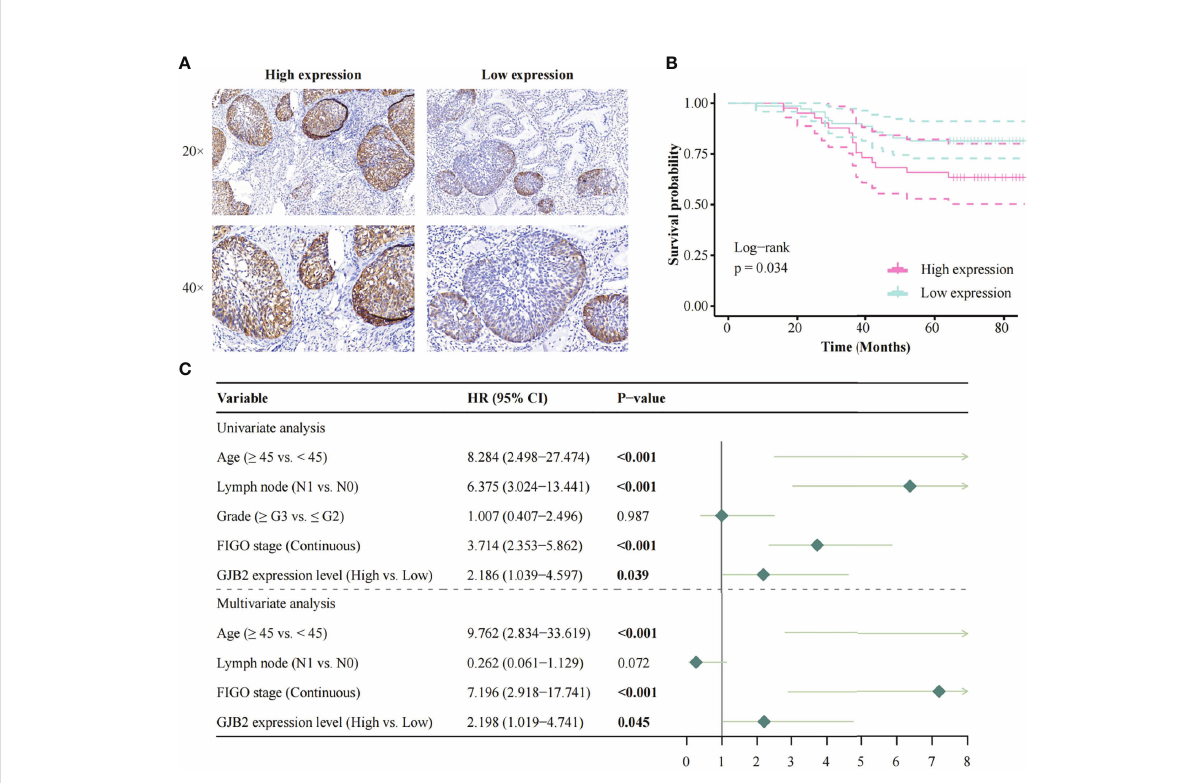
FIGURE 2 Survival analysis based on the OBC data. (A) The representative images of high GJB2 and low GJB2 expression; (B) Impact of GJB2 expression on overall survival in CC; (C) Forest plot for the univariate and multivariate Cox proportional hazard regression model. OBC, Outdo Biotech. Co., Ltd.; HR, Hazard